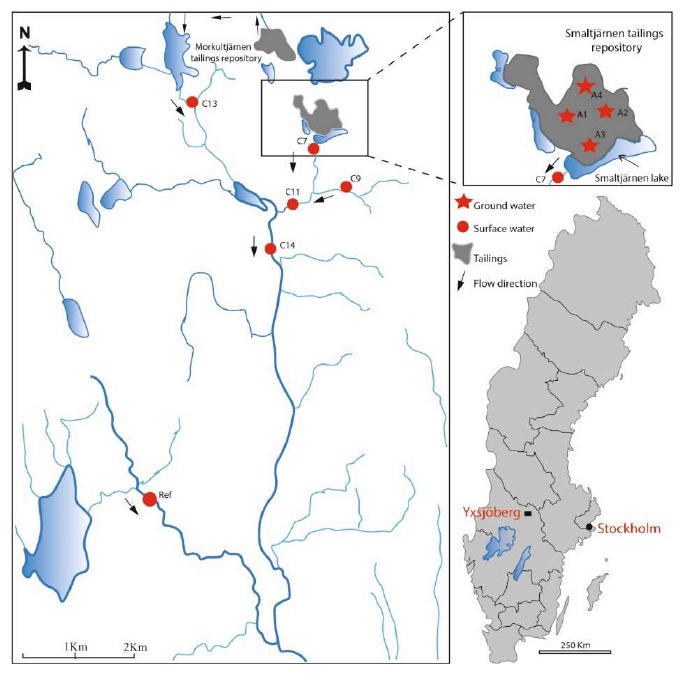
Figure 1. A modified map (based on [25]) of the study area showing the sampling points used for this study.